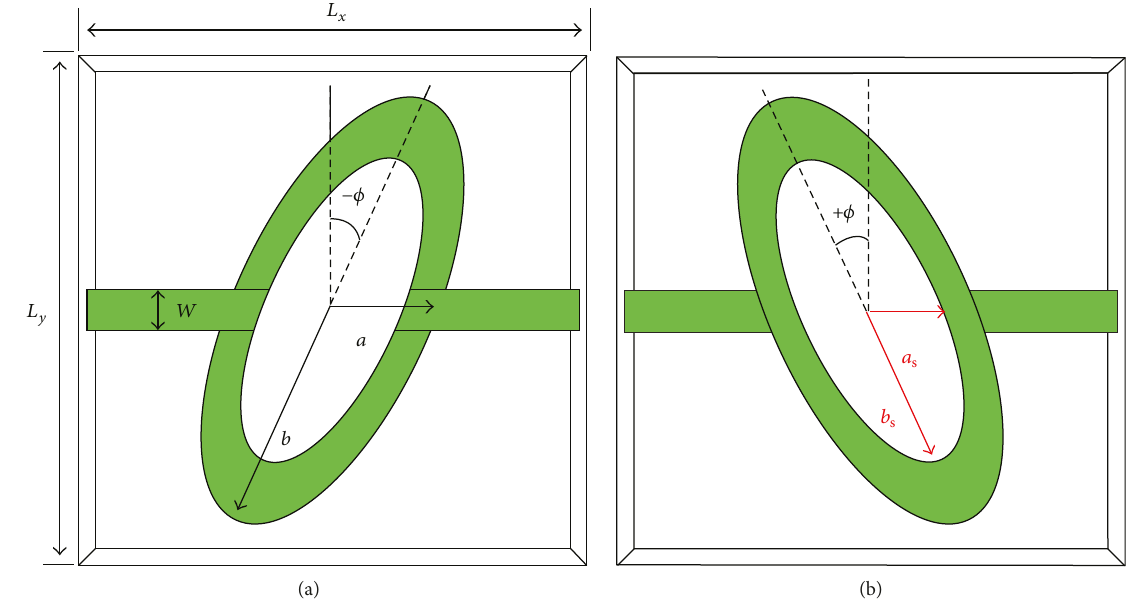
Figure 2: CST model for the unit cell: (a) upper layer; (b) lower